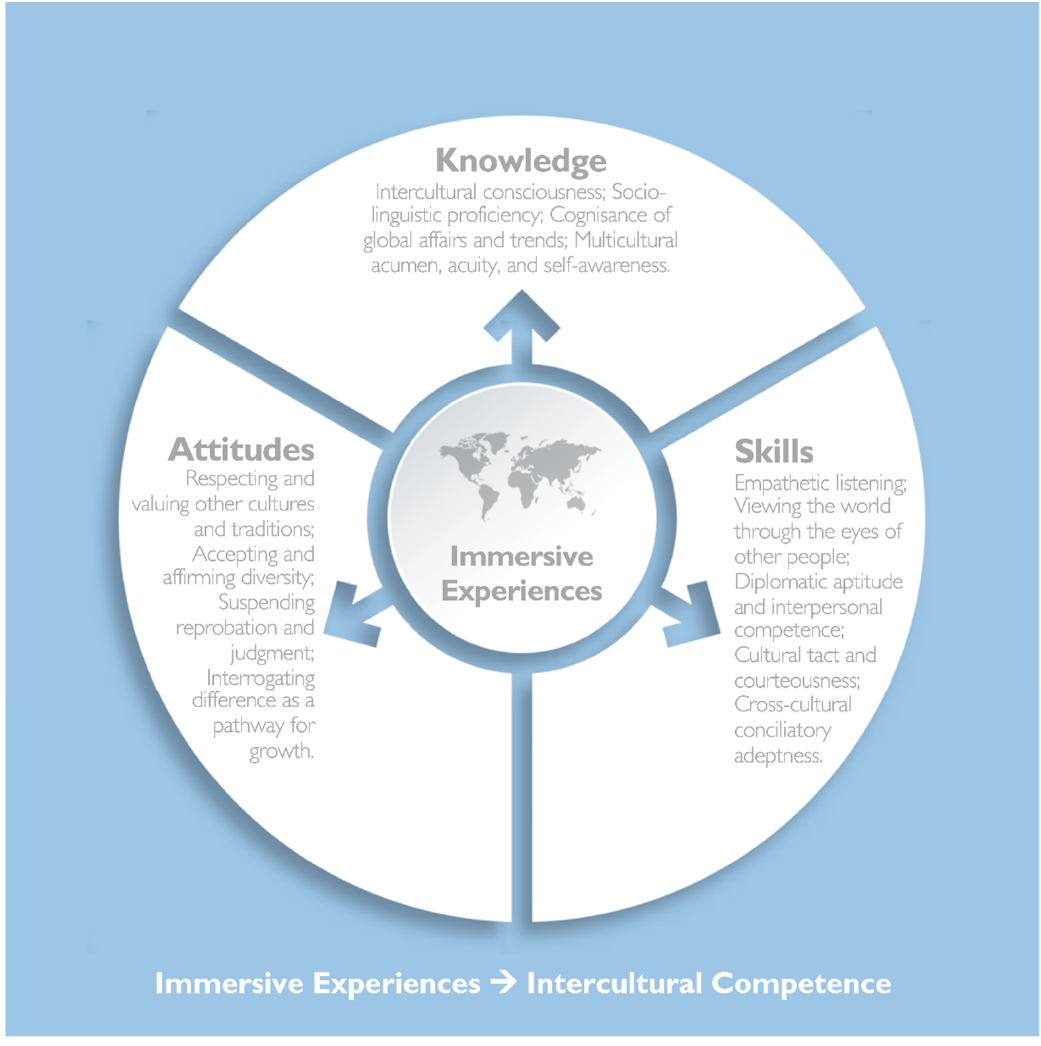
Figure 6. Deardorff’s (2006) three constituent elements of intercultural competence (knowledge, Figure 6. Deardorff (2006) three constituent elements of intercultural competence (knowledge, skills, and attitudes) may be skills, and attitudes) may be visualised as being directly informed by the central role played by fully visualised as being directly informed by the central role played by fully embodied interculturally immersive embodied interculturally immersive experiences.